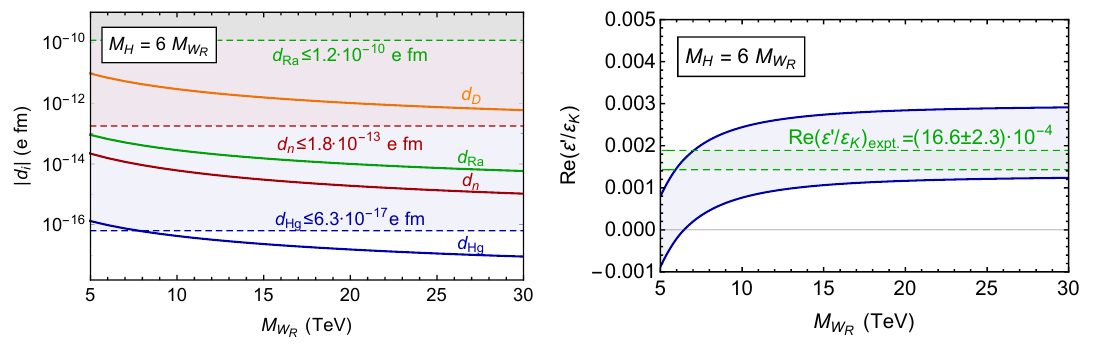
Figure 2 . The left panel depicts the ∆ χ 2 = { 1 , 2 , 4 , 10 } regions in the M W marginalizing over the other LR and CKM parameters. A Peccei-Quinn mechanism is applied. The gray line shows the M 8 M region where couplings in the Higgs potential become non- H > W R perturbatively large [74]. The right panel shows the allowed parameter space in the M plane for fixed M = 6 M , while marginalizing with respect to the remaining parameters. Both H W R panels correspond to the choice s = +1 . q